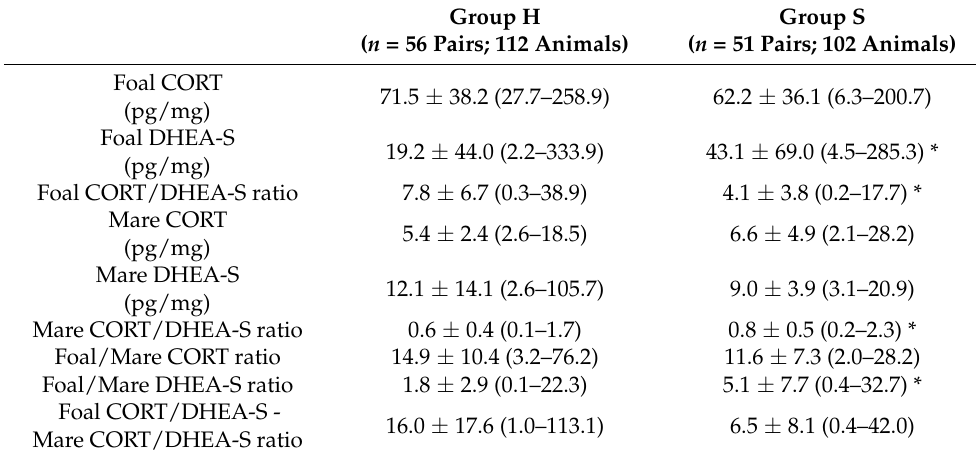
Table 2. Results of study 1 in the two groups (Healthy—H and Sick—S). Data are expressed as mean ± standard deviation (min-max). * Superscript asterisk in a row indicates a significant difference ( p < 0.05) among groups with independent samples t